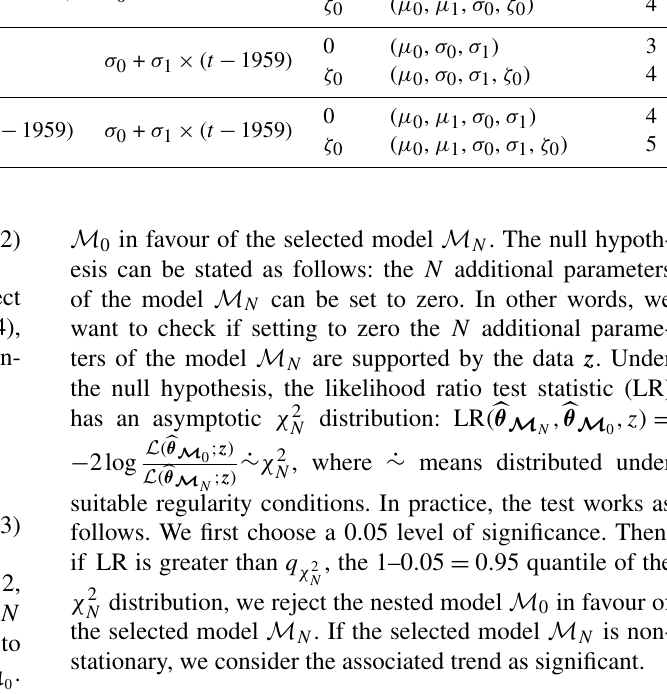
Table 2. Statistical models considered for annual maxima of GSL are based on the Gumbel or the GEV distribution and are extensions of the stationary Gumbel model. For non-stationary models, the location and/or the scale vary linearly with years t after the starting year 1959. Model type Distribution